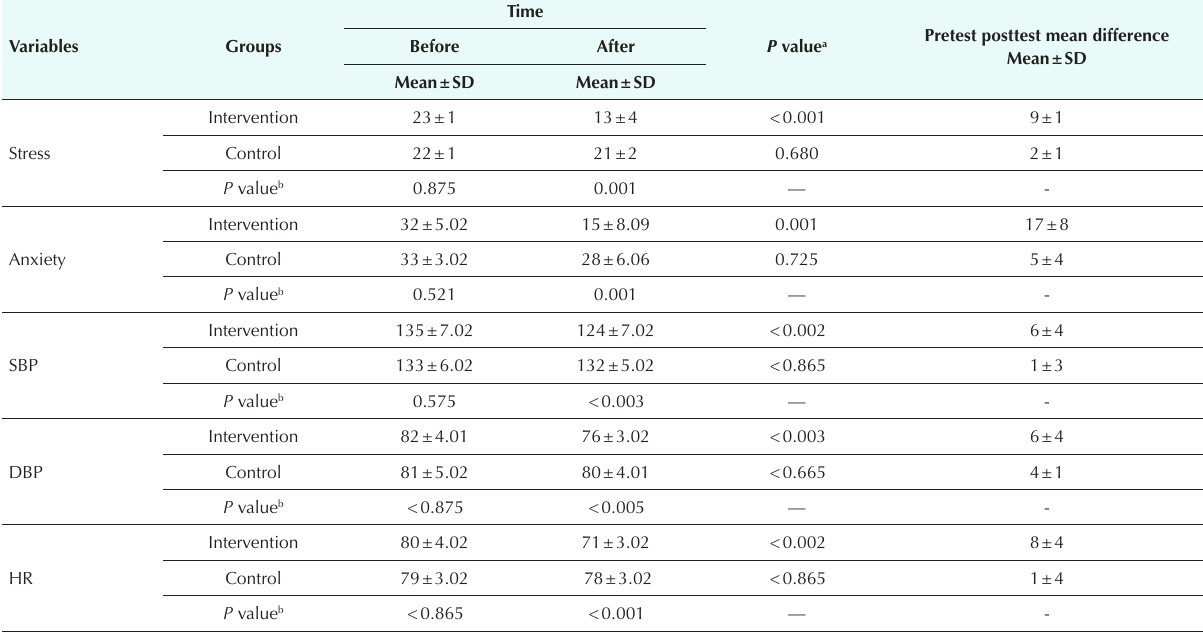
Table 2. Within- and between-group comparisons respecting the means scores of stress and anxiety and the mean values of SBP, DBP, and HR